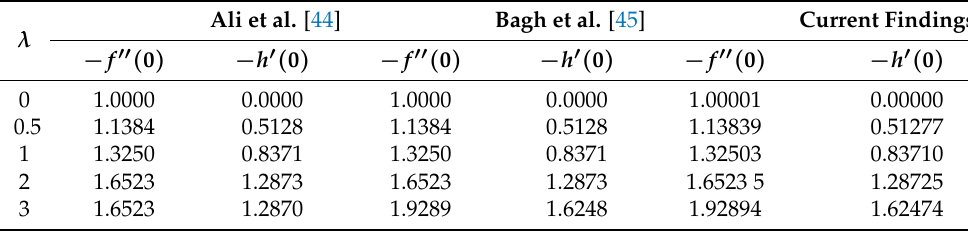
Table 2. Computing f (cid:48)(cid:48) ( 0 ) and h (cid:48) ( 0 ) values with distinct values of parameters λ and β = Fr = 0.